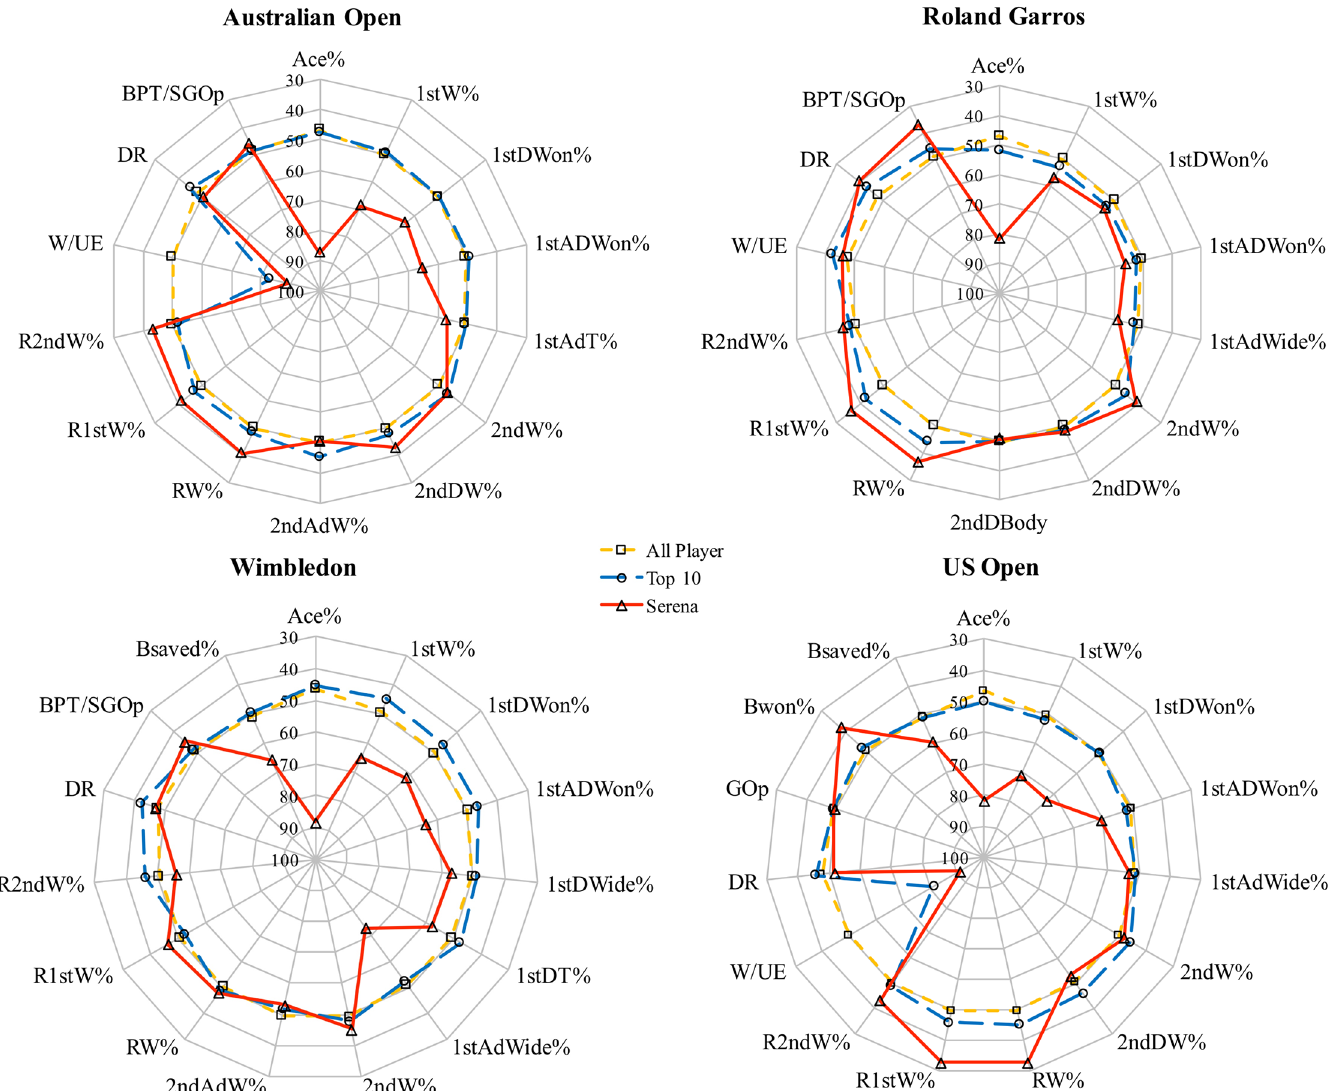
Fig 3. Performance profiles of percentage of evaluation score (%ES) for: All female players, Top-10 players and Serena Williams in four Grand